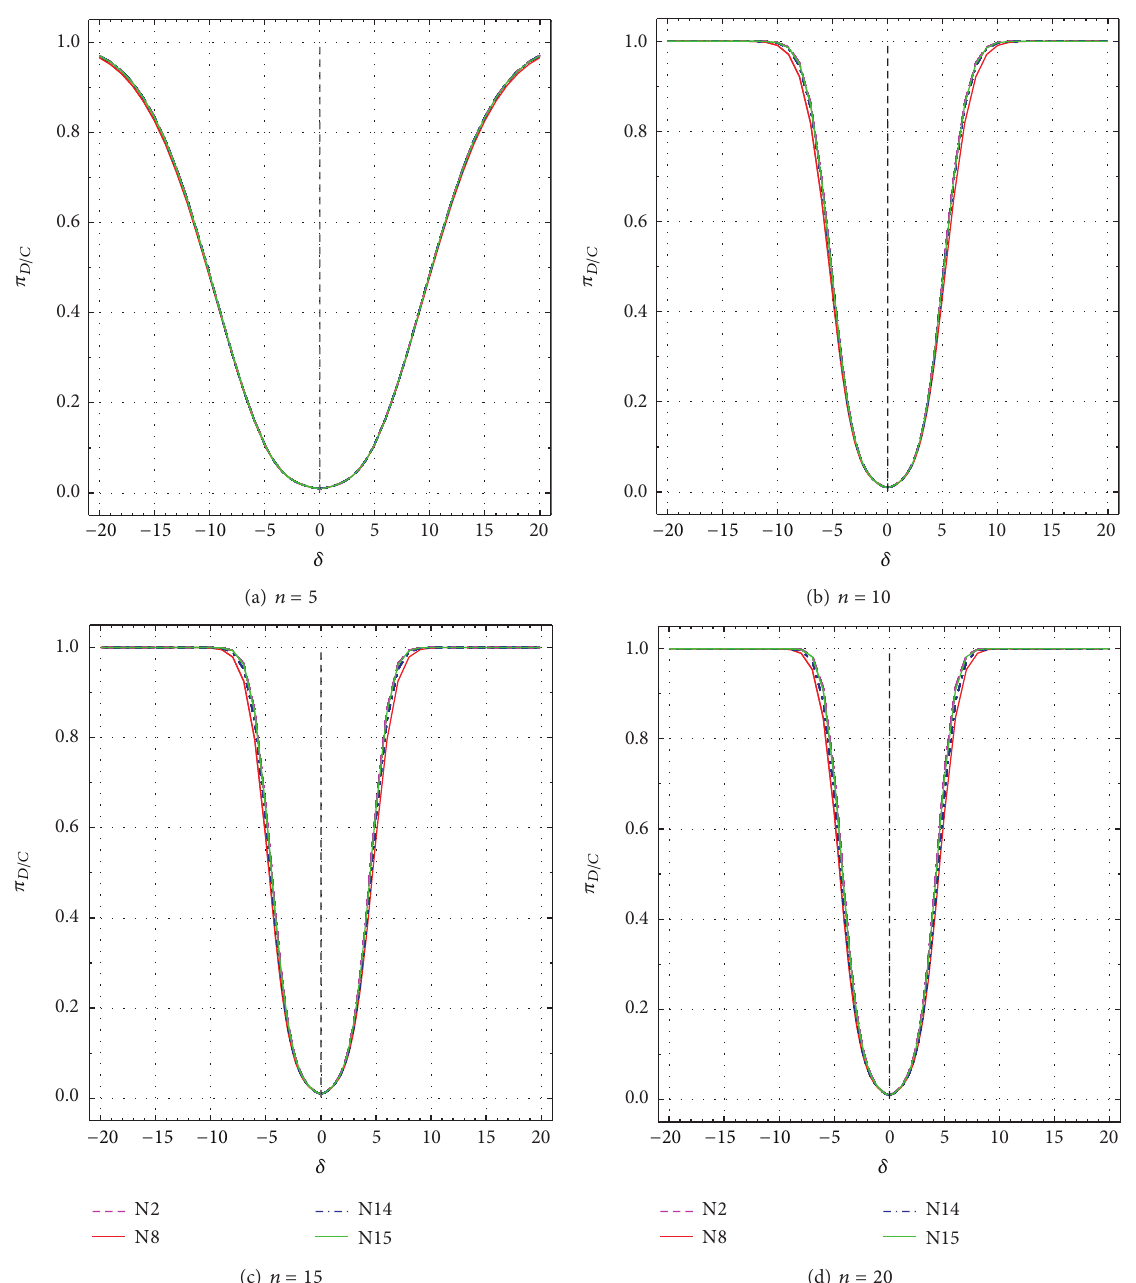
Figure 11: Test Performance Criterion ( 𝜋 𝐷|𝐶 , or Conditional Power P5) as a function of 𝛿 from − 20 to +20 for all tests N2, N8, N14, and N15. (a) 𝑛 = 5 ; (b) 𝑛 = 10 ; (c) 𝑛 = 15 ; and (d) 𝑛 = 20